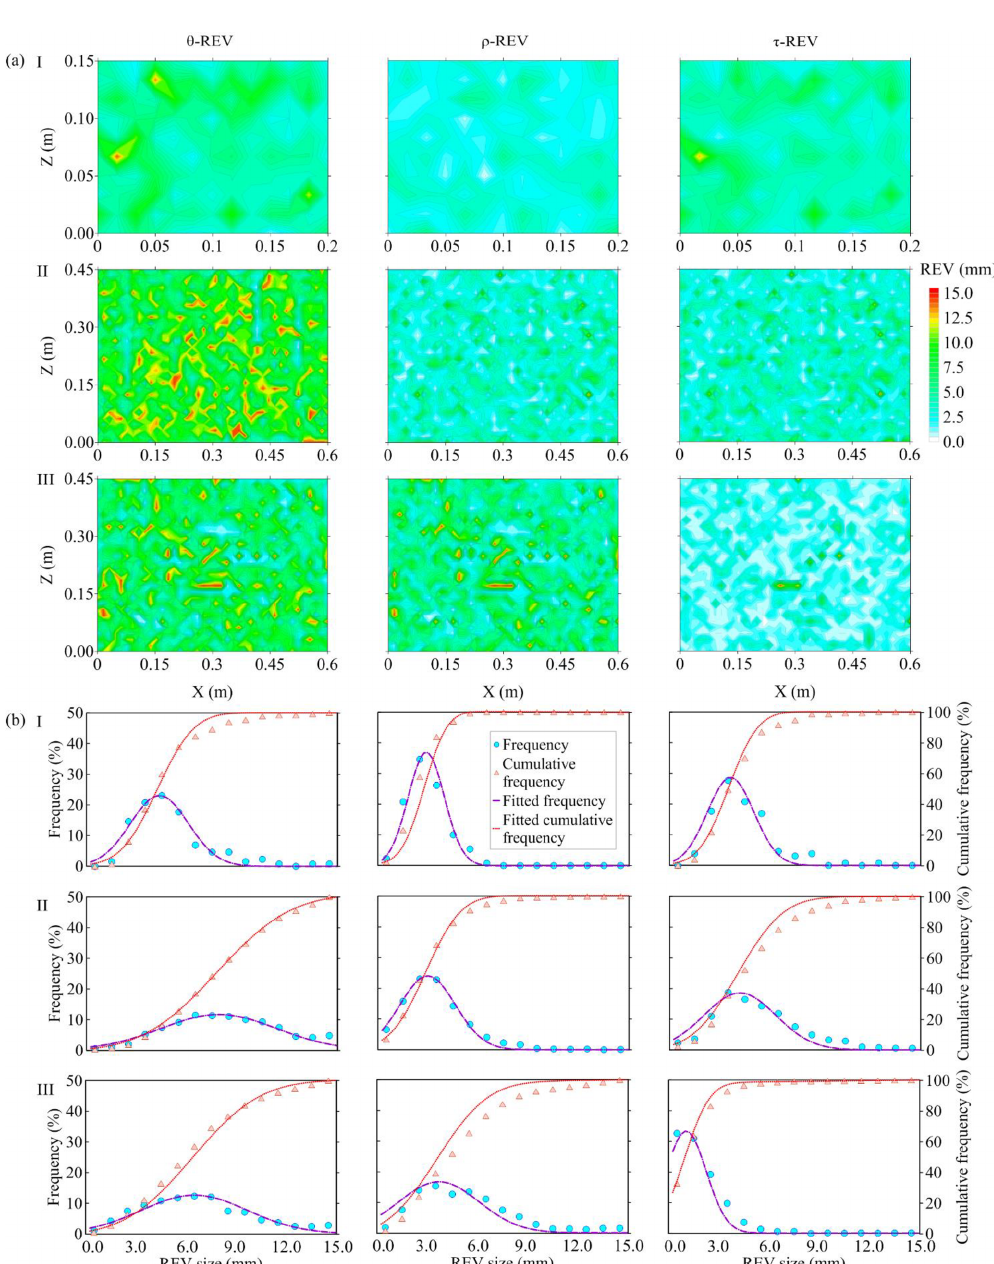
Figure 5. (a) The distributions of minimum REV sizes of porosity, sand density, and tortuosity for Experiments I–III; (b) the frequency of minimum REV sizes of experiments and fitted